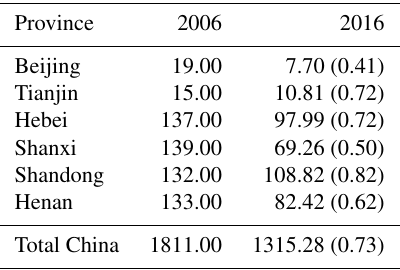
Table 1. Anthropogenic BC emissions in China by province in 2006 a and 2016 b (units: Gg/year).